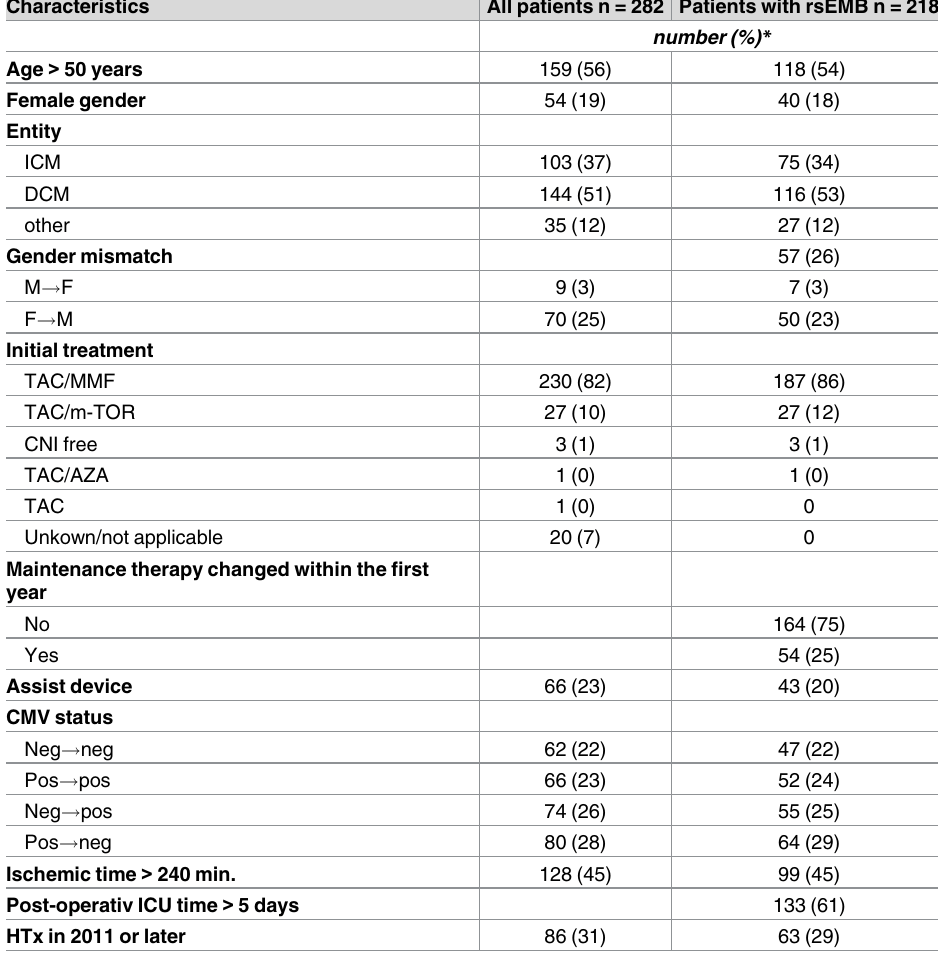
Table 2. Patient